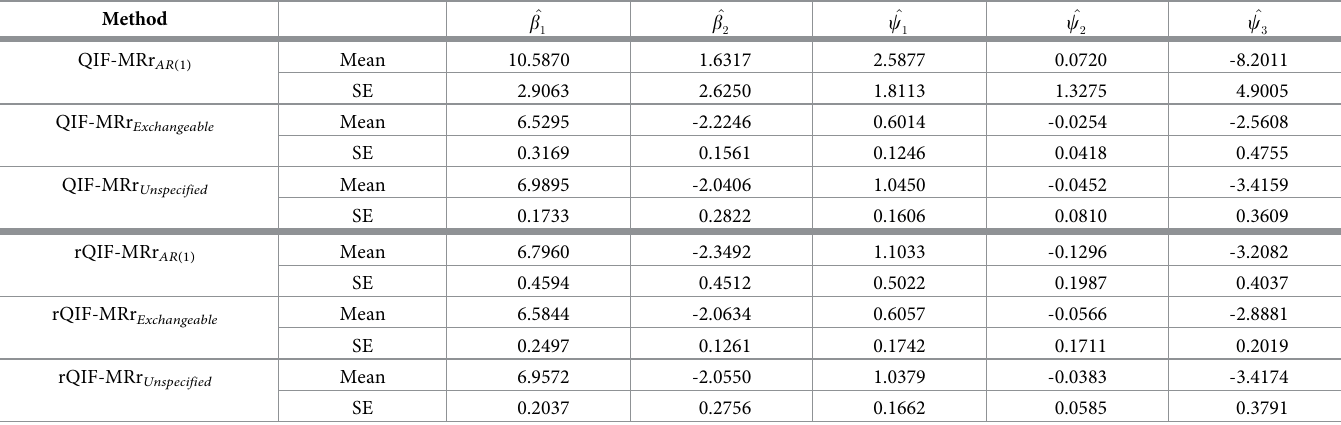
Table 5. Parameter estimation of Warfarin data with AR(1), exchangeable, and unspecified working correlation structures for QIF-MRr and rQIF-MRr.